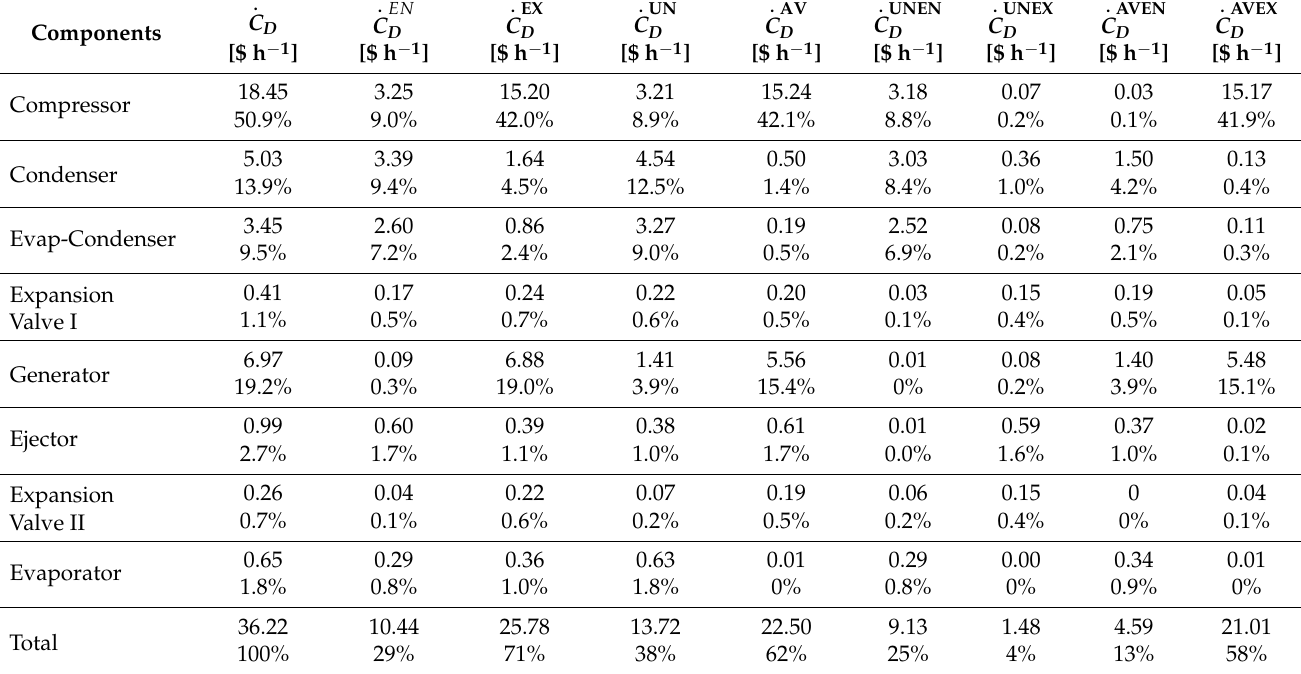
Table 8. Exergy destruction cost rate of each system